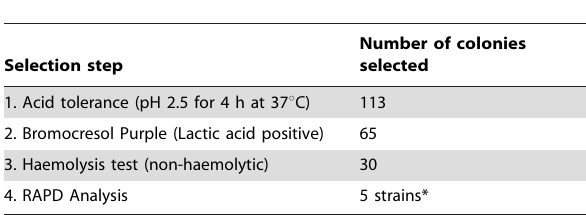
Table 1. Screening of LAB from fermented aloe